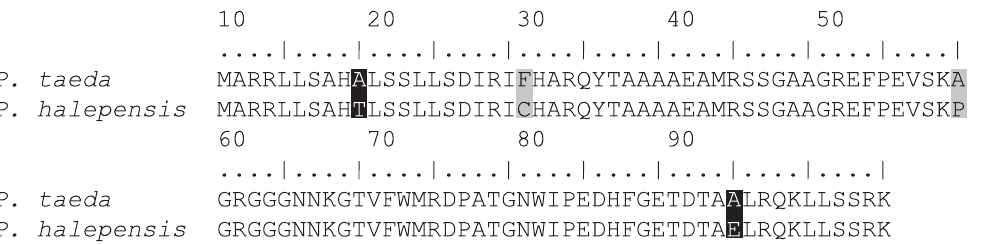
Figure 5. Alignment of the predicted amino acid sequences of the Pinustaeda 7-56 LEA gene (top) and the Pinushalepensis 15r LEA mRNA (bottom; GenBank Accession No. AY705798.1) suggest that the proteins differ at four amino acids (highlighted residues). Interspecific single nucleotide differences highlighted in light gray do not result in a change in overall polarity and/or charge. However, differences highlighted in black result in a polarity and/or charge difference (e.g., A= nonpolar, neutral; T = polar, neutral; E = polar, negative).